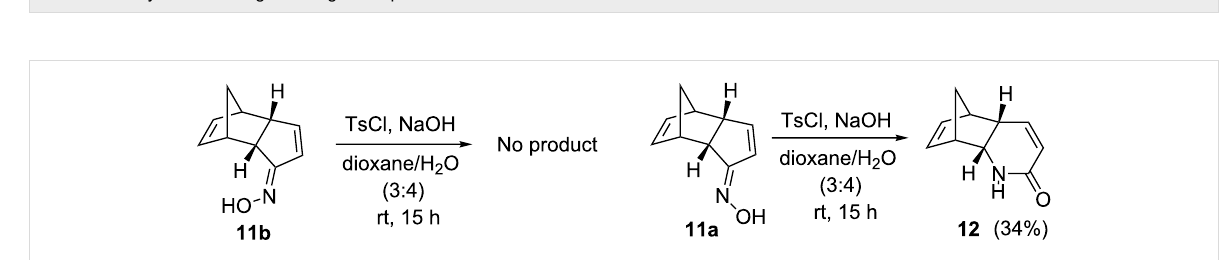
Scheme 4: Synthesis of ring-rearrangement precursors.